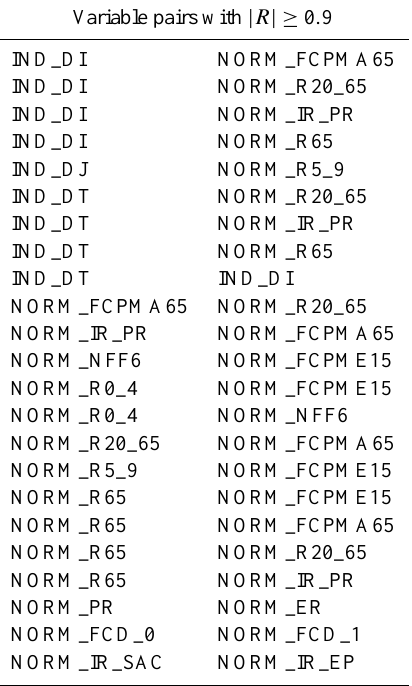
Table 2. Variable pairs within the correlation matrix with extreme multicollinearity ( | R | ≥ 0 . 9). In grey are the variables excluded from the PCA. In some pairs both variables are marked as excluded because of other high correlations they exhibited with different vari-